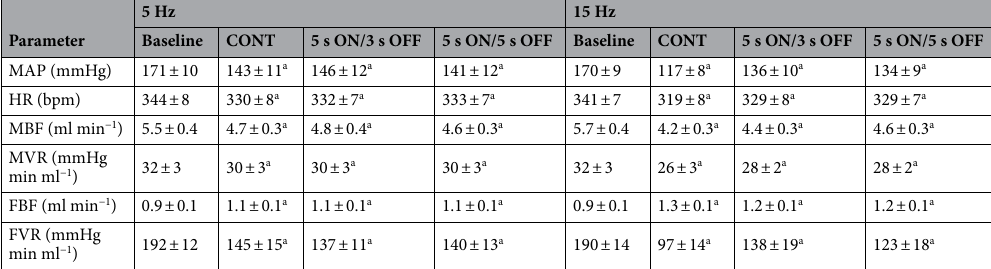
Table 1. Baseline and peak hemodynamics recorded in response to continuous (CONT) and intermittent (5 s ON/3 s OFF and 5 s ON/5 s OFF) stimulation of the aortic depressor nerve (ADN) using low (5 Hz) and high (15 Hz) pulse frequencies delivered for 20 s at 0.4 mA and 0.2 ms in pentobarbital-anesthetized spontaneously hypertensive rats. The data are presented as mean ± SEM ( n = 8–9) and were analyzed by a two-way ANOVA followed by Bonferroni’s post hoc test. MAP mean arterial blood pressure, HR heart rate, MBF mesenteric blood flow, MVR mesenteric vascular resistance, FBF femoral blood flow, FVR femoral vascular resistance. a P < 0.05 versus respective baseline